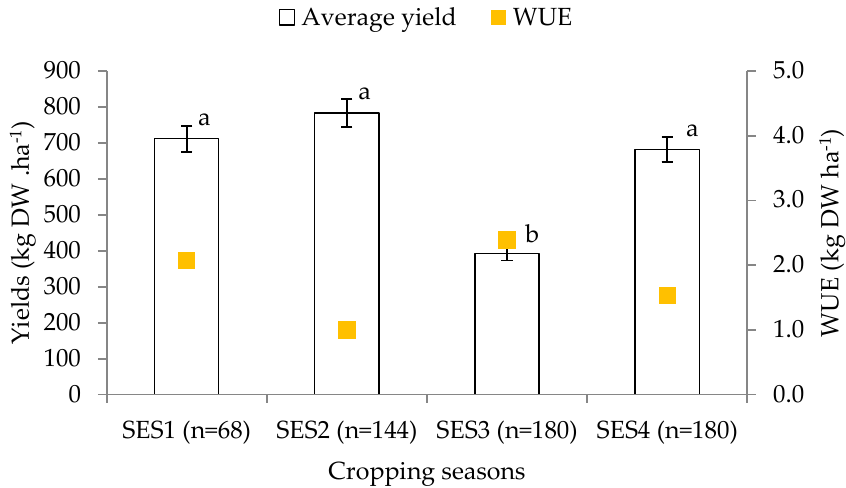
Figure 5. The pearl millet mean yields and water use e ffi ciency (WUE) recorded for four seasons. The bars are percentage errors. Di ff erent letters indicate significant di ff erences in pearl millet yield means at p < 0.05: Later analysed by Holm’s sequential Bonferroni post-hoc test correction for multiple comparisons of